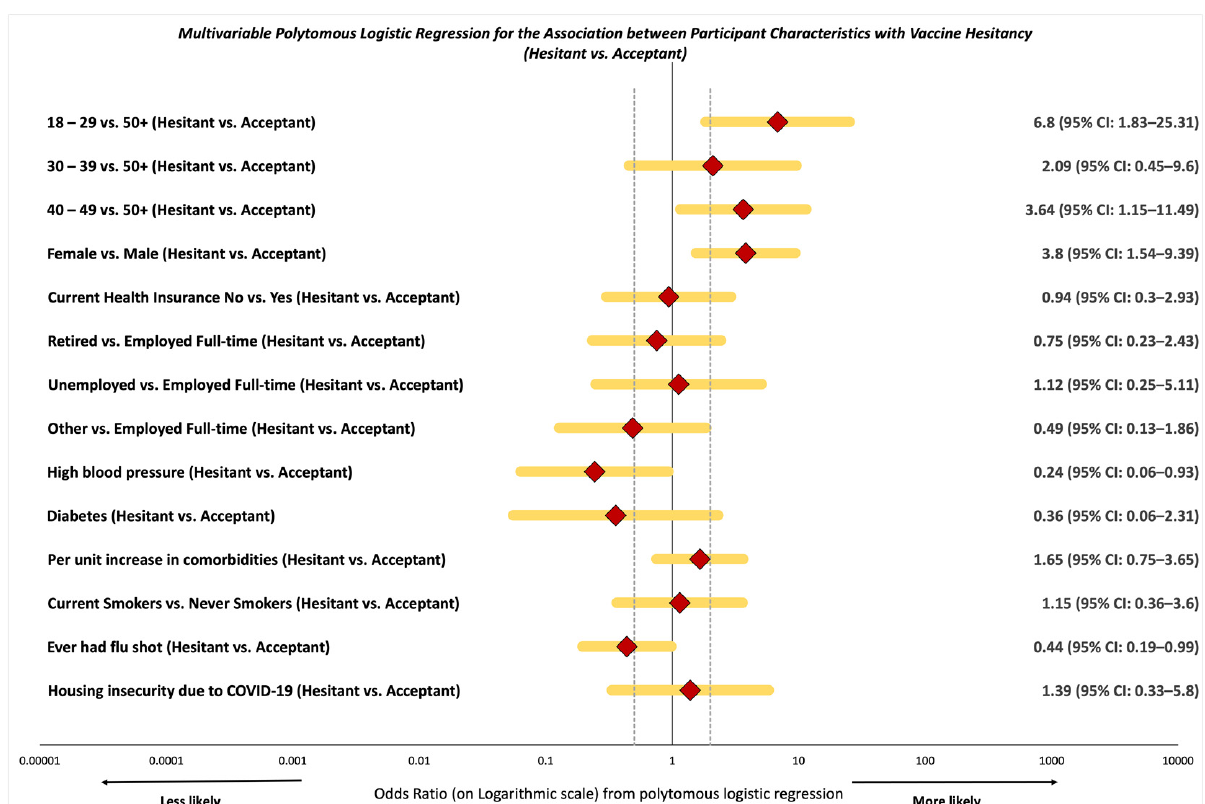
Figure 2. Multivariable polytomous logistic regression for the association between select participant characteristics with being vaccine-hesitant vs. acceptant, among 257 community participants within the SPARTA and 100 Black Men of Augusta survey by vaccine hesitancy groups.